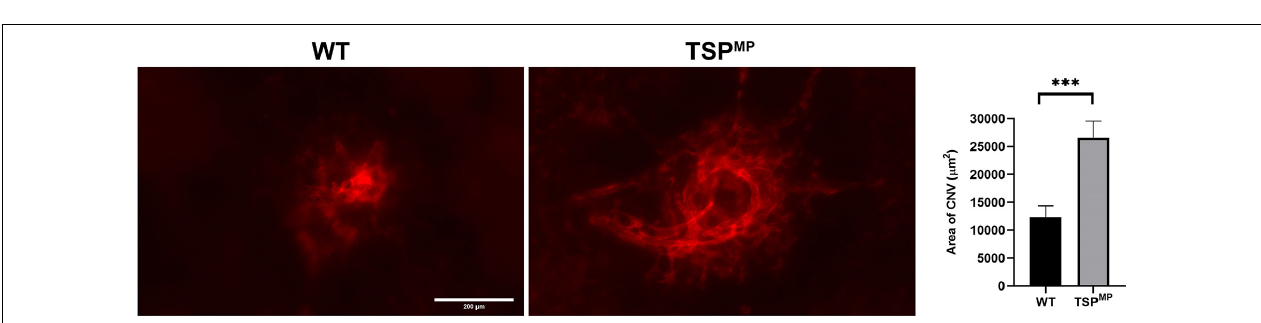
FIGURE 6 | Increased choroidal neovascularization in mice lacking TSP1 expression in endothelial cells. Choroidal neovascularization was induced in 6-weeks old male and female wild type (WT) and TSP1 conditional mice by laser photocoagulation-induced rupture of Bruch’s membrane. After 14 days, the eyes were sectioned at the equator, and the anterior half/vitreous/retina removed. The remaining eye tissue was stained with anti-ICAM-2 and the area of neovascularization quantitated (**** P < 0.0001). Scale bar = 100 µ m.